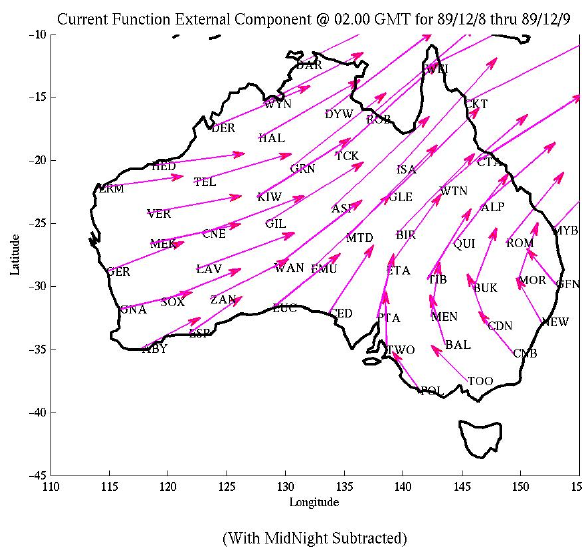
Fig. 7. As for Fig. 1 but for 02:00 UT on 9 December 1989. Arrow lengths: 5 ◦ longitude length is equivalent to 28nT.